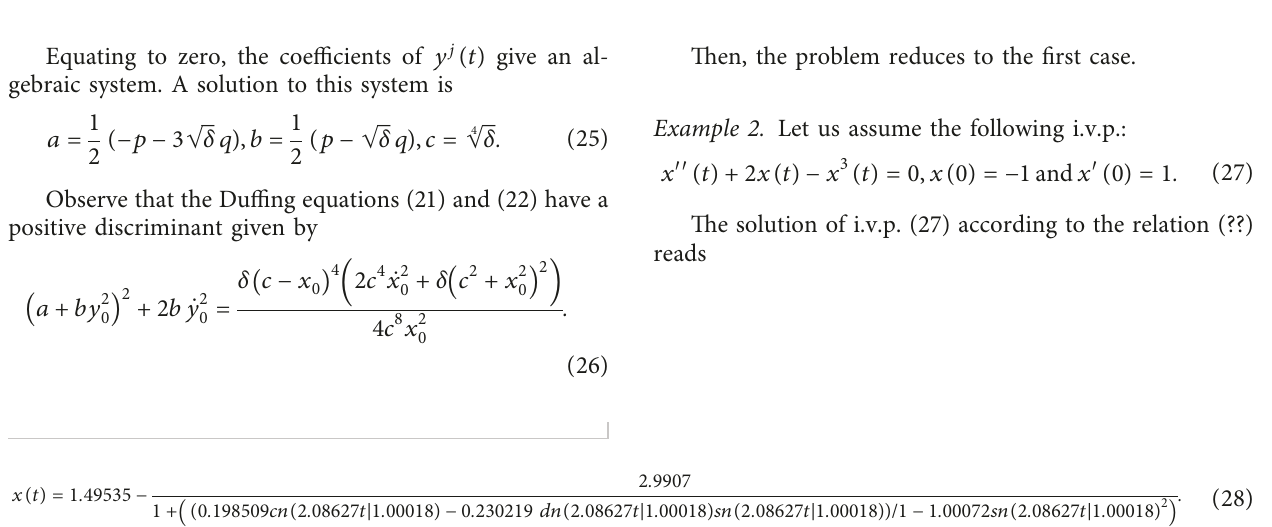
Figure 1: Comparison between the exact solution and the numerical solution for Example